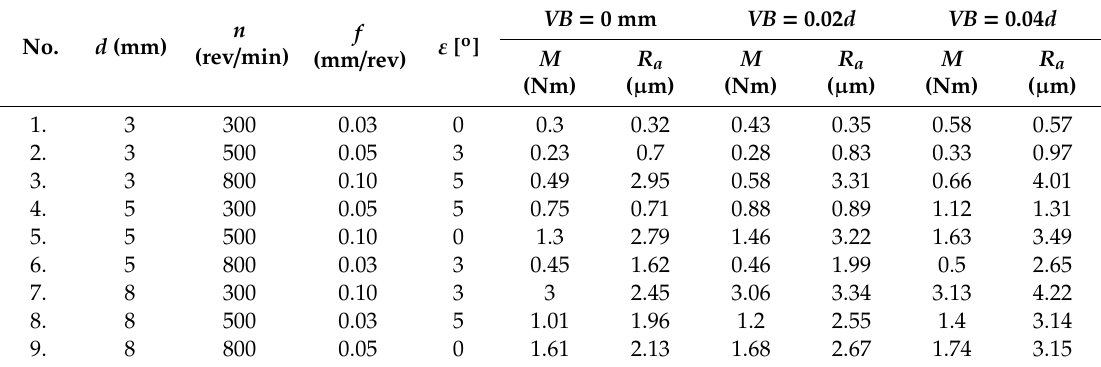
Table 6. The experimental results.